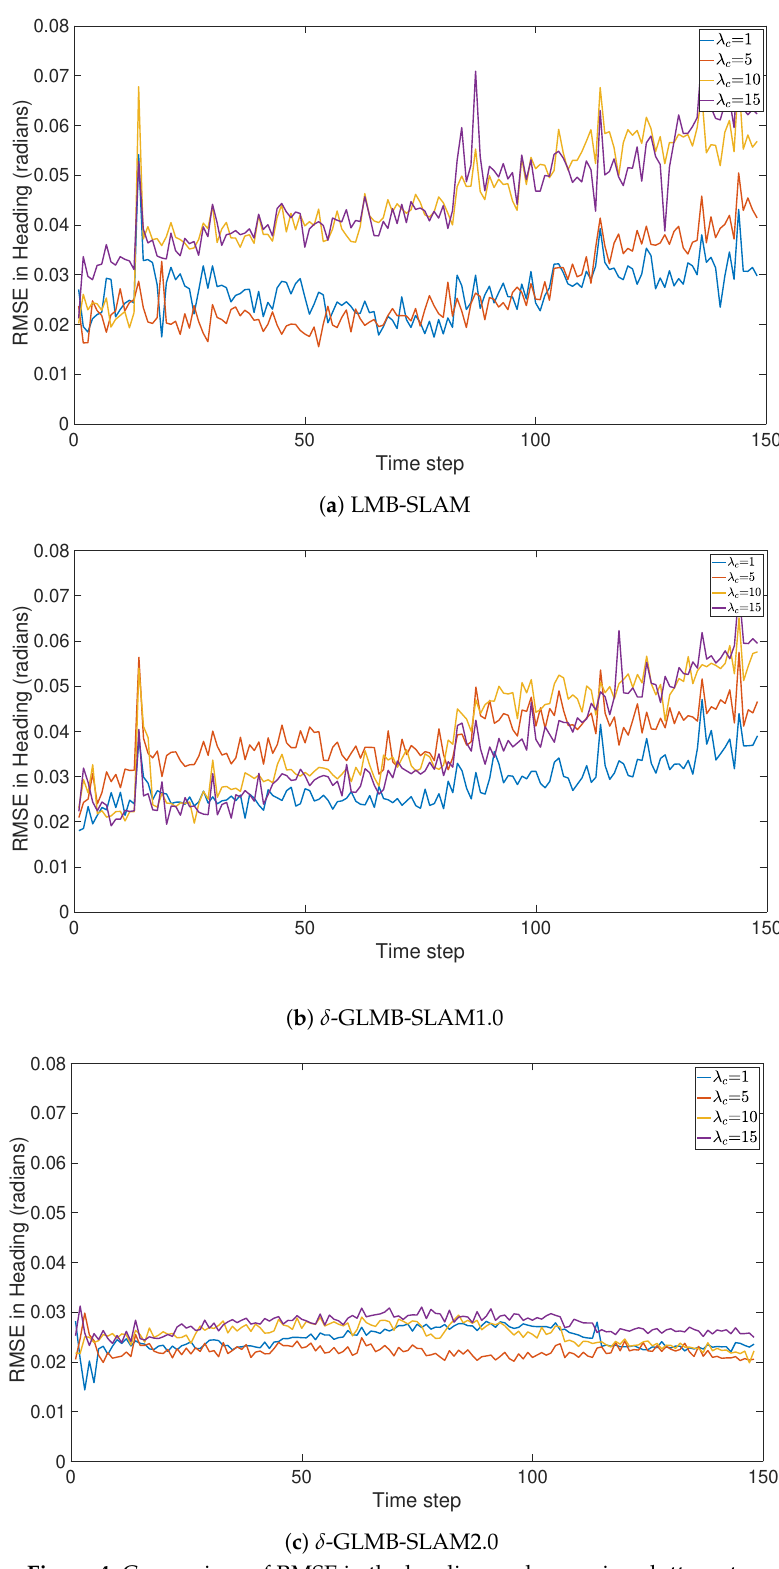
Figure 4. Comparison of RMSE in the heading under varying clutter